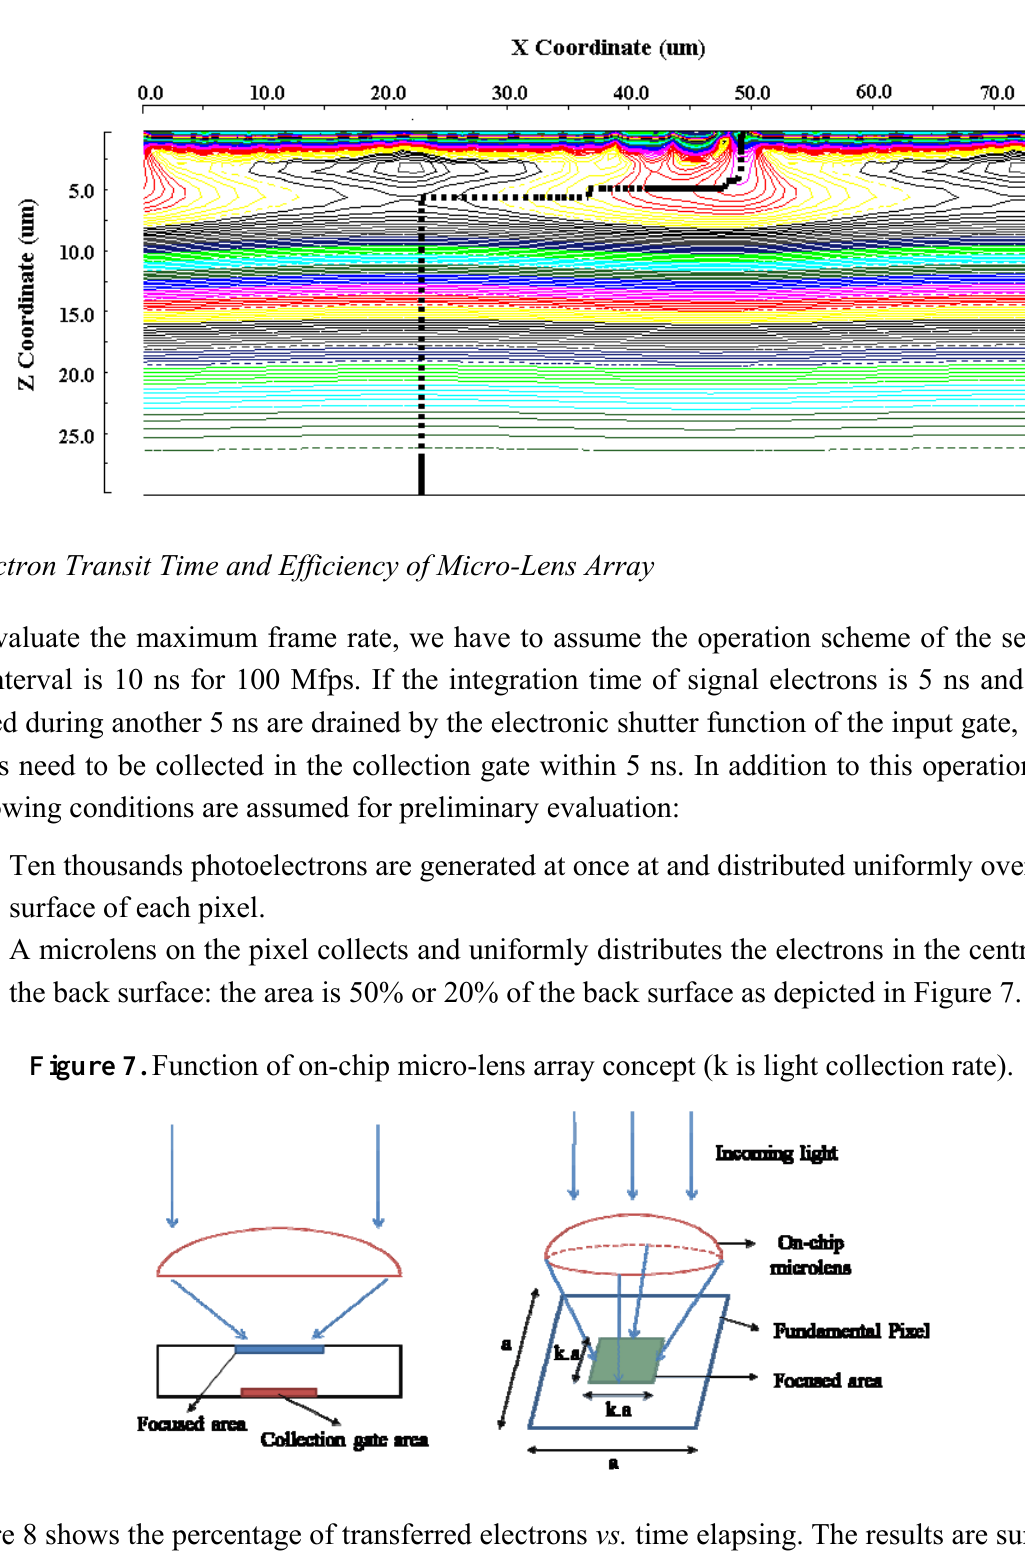
Figure 6. Cross section profile and an electron path from the backside of the sensor to the collection gate.